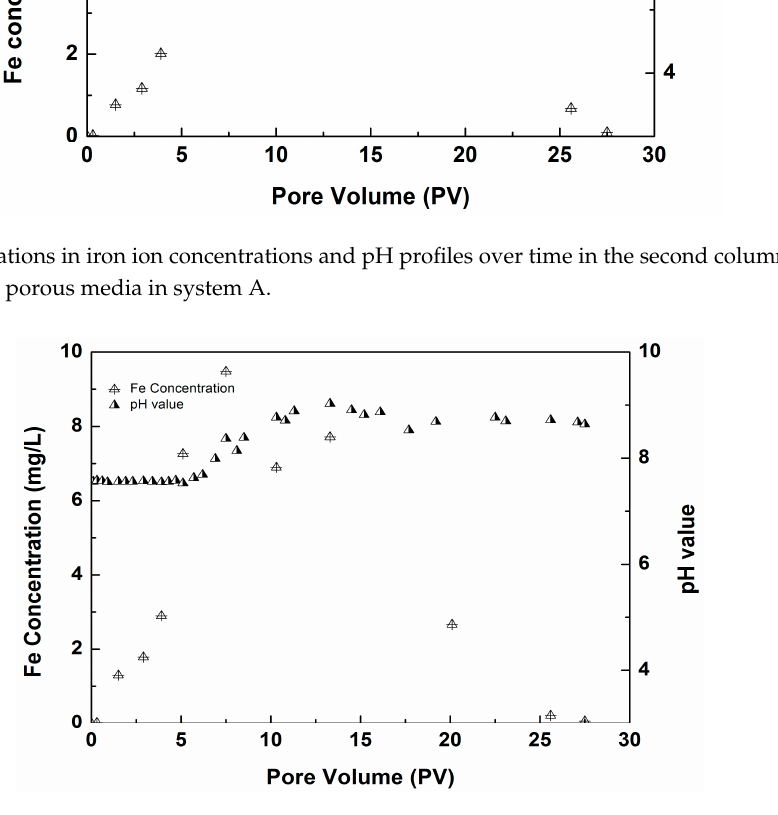
Figure 8. Variations in iron ion concentrations and pH profiles over time in the second columns of the heterogeneous porous media in system B.